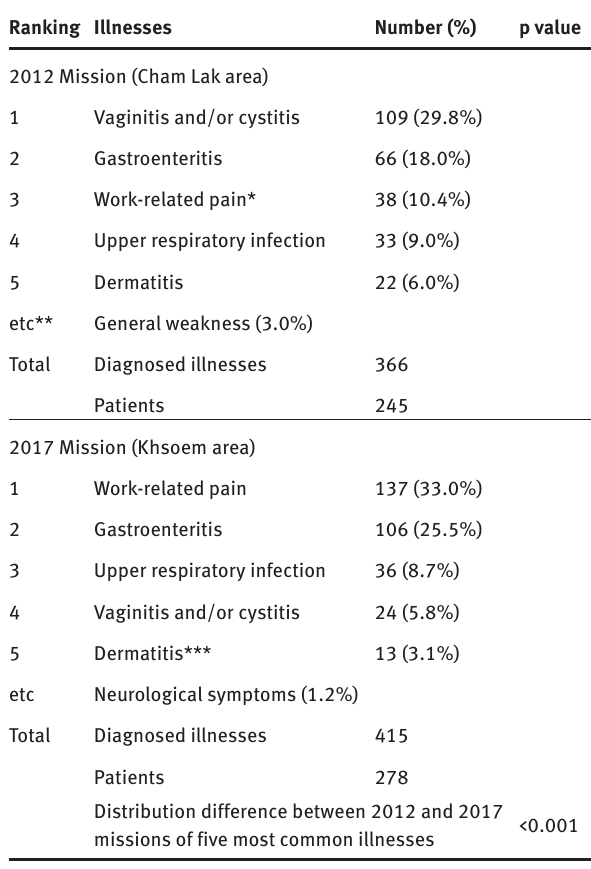
Table 3: Common illnesses of the adult patients